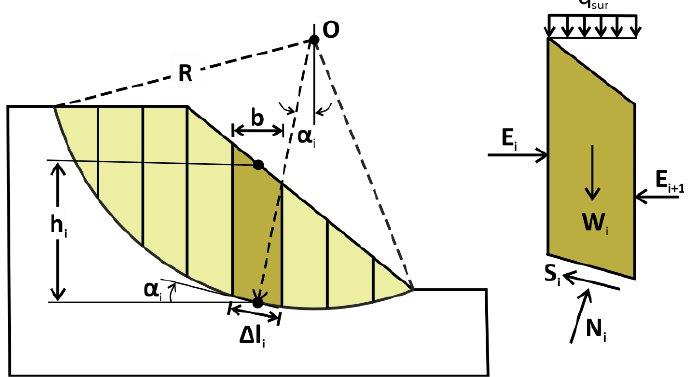
Figure 6. Circular slip surface and forces applied to a slice in the simplified Bishop method.